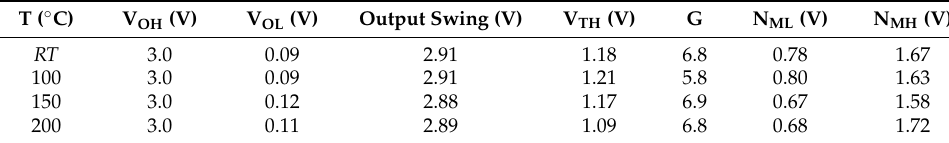
Table 3. Noise margins for inverters at different